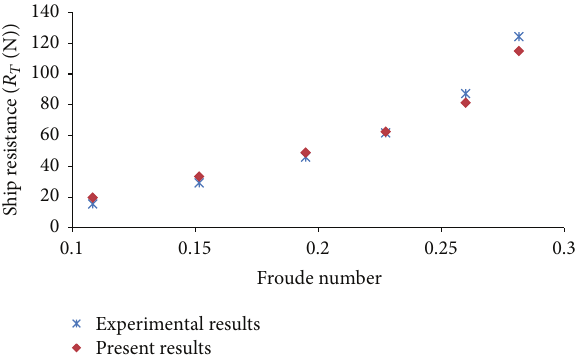
Figure 6: Comparison of computed and experimental results.